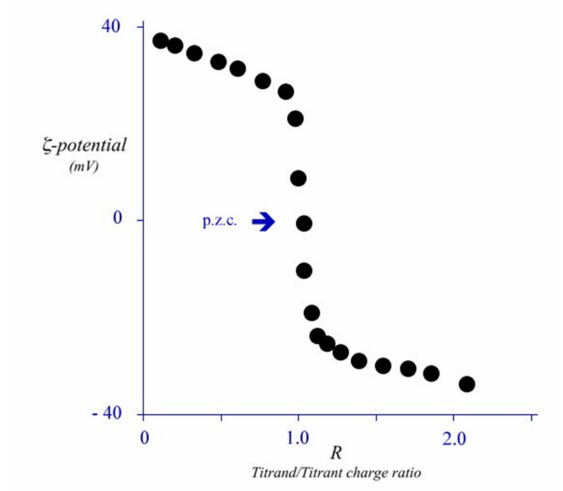
Figure 8. ζ -potential, in mV, vs. versus the titrant to titrand, R , ratio: if R (cid:27) 1, the ζ -potential is 0. The curve is grossly symmetrical with respect to the p.z.c. the inflection point in the graph. Data refer to sunflower oil dispersed by DPDC (Dipalmitoyl Phosphatidyl choline), in 0.0250 aqueous NaCl, at 35.0 ◦ C. The titrand / titrant ratio, R , depends on